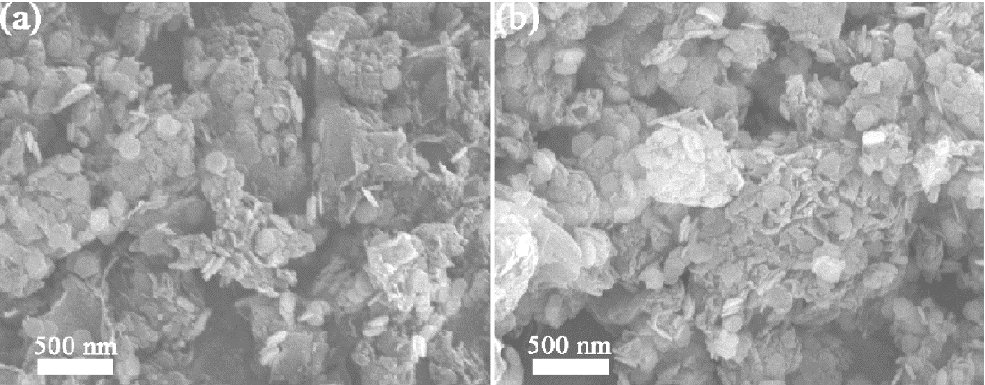
Figure 5. SEM images of ( a ) 10 wt.% α -Fe 2 O 3 @g-C 3 N 4 photocatalyst and ( b ) 20 wt.% α -Fe 2 O 3 @g-C 3 N 4 photocatalyst.